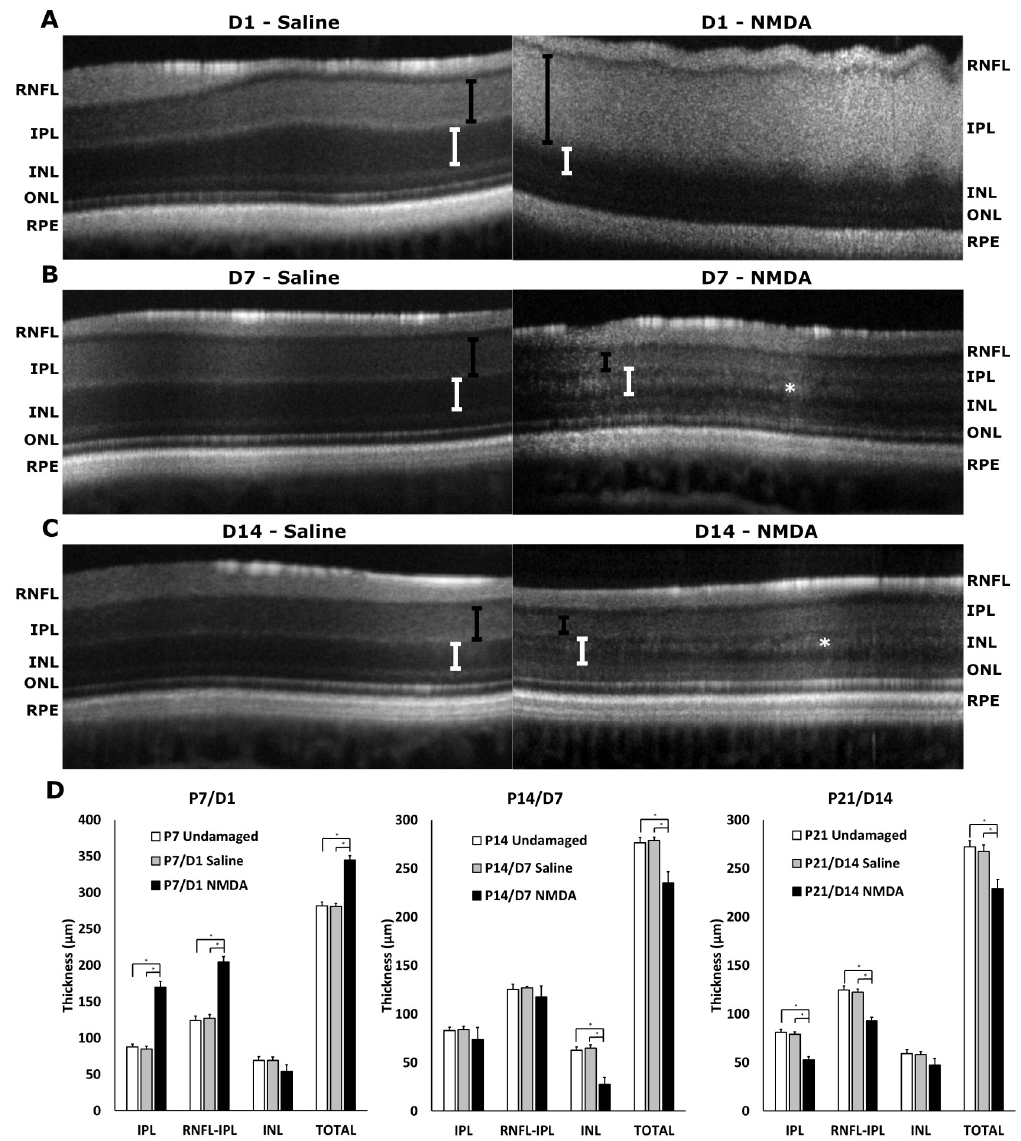
Fig 4. SD-OCT analysis of NMDA-treated and corresponding control eyes. Representative b-scans of D1 vehicle (saline, left) and D1 NMDA (right) showing edema in IPL (A), D7 vehicle (saline, left) and D7 NMDA (right) (B), and D14 vehicle (saline, left) and D14 NMDA (right) (C). (D) Analysis of retinal thicknesses of the IPL, RNFL-IPL combined, INL, and total thickness between NMDA and saline (vehicle) treated eyes at P7/D1 to P21/D14 post injection and their respective age- matched untreated controls. Black brackets show IPL thickness, white brackets show INL thickness, asterisk denotes hyperreflective layer. Error bars are shown as standard deviation. Abbreviations: RNFL—retinal nerve fiber layer, IPL—inner plexiform layer, INL—inner nuclear layer, ONL—outer nuclear layer, RPE—retinal pigment epithelium.